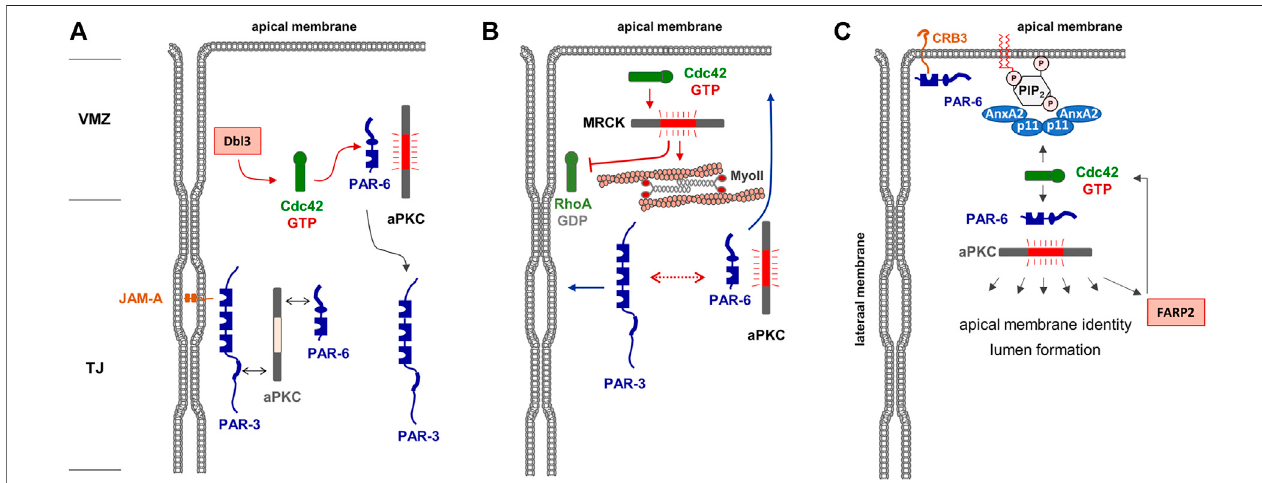
FIGURE 2 | Regulation of apical membrane identity in polarized epithelial cells. (A) The Par — aPKC complex is localized at the TJs, most likely through PAR-3 interacting with JAM-A. The Cdc42 GEF Dbl is localized at the vertebrate marginal zone (VMZ) and activates Cdc42, which in turn interacts with PAR-6 and induces a conformationalchangeofPAR-6thatallowsactivationofaPKC.PhosphorylationofPAR-3resultsinthedissociationofPAR-3.Notethatthisisadynamiccycle,andthat the stable association of the heterotrimeric PAR-3 — aPKC - PAR-6 complex may be short-lived. (B) Active Cdc42 activates MRCK which stimulates actomyosin contractility-mediated segregation of PAR-3 and PAR-6 — aPKC (dotted line with double arrows) to lateral and apical membrane domains, respectively (blue arrows). In addition, MRCK inhibits RhoA at the lateral membrane domain. (C) A tetrameric complex of Annexin A2 (AnxA2) and p11 is localized in the apical membrane by interacting with phosphatidyl-inositol-4,5-bisphosphate (PIP 2 ). This complex recruits and activates the PAR-6 — aPKC complex which phosphporylates various substrates involved in apical membrane identity and lumen formation. Among its substrates is the Cdc42 GEF FARP2, which catalyzes GDP-exchange of Cdc42, providing a possible positive feedback loop of Cdc42 activation in the apical membrane. Note that CRB3 present in the apical membrane may provide an additional anchor for PAR-6 and possibly the PAR-6 — aPKC complex.